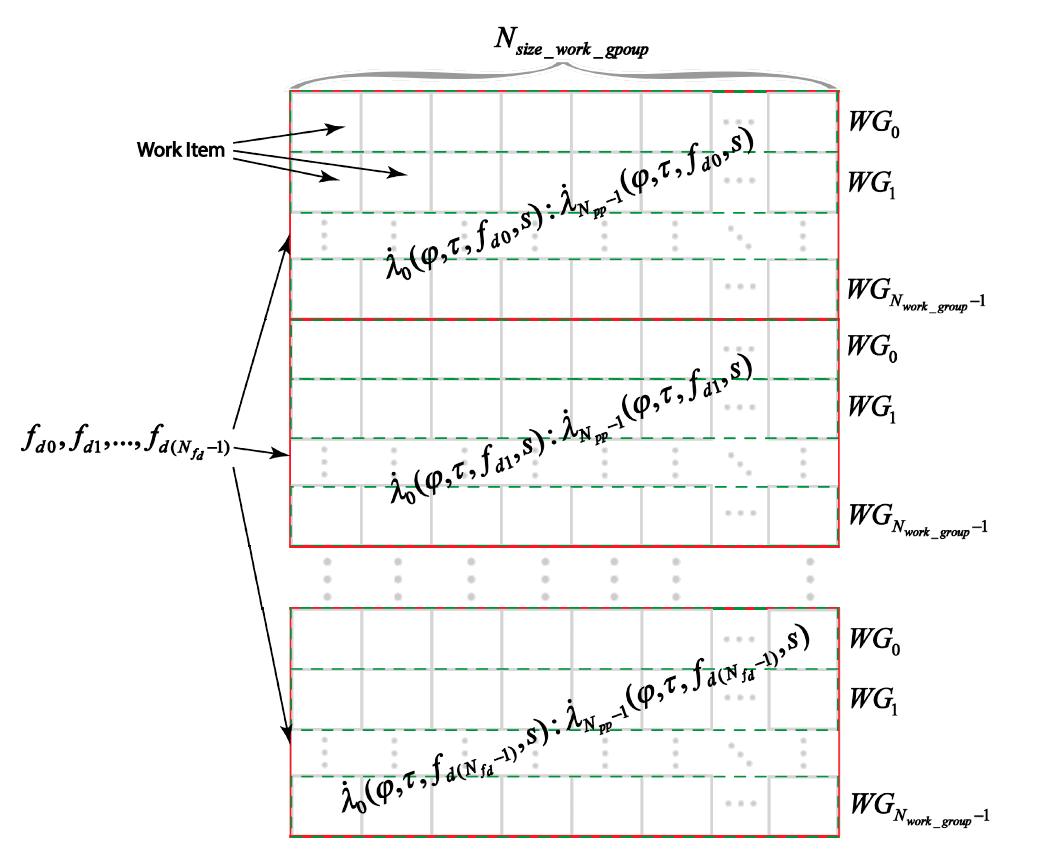
Figure 7. Distribution of computations between GPU work items.